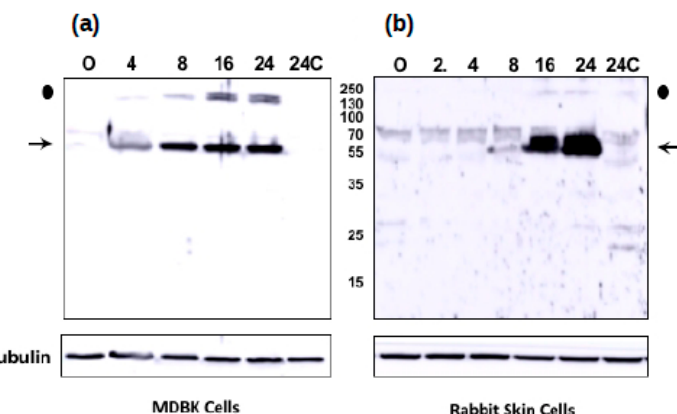
Figure 7. Immunoblot for ORF-A protein production. MDBK (panel a ) or RS cells (panel b ) were infected with BoHV-1 at the indicated times after infection (hours). Proteins were separated via SDS-PAGE gel (50 ug protein/lane). Western blots were probed using the ORF-A peptide specific antiserum. Tubulin was used as a protein loading control. These results are the average of three independent experiments. A protein around 55 kDa was detected in both infected cell types. Peptide-speific antisera from two rabbits yielded similar results in both cell lines. Data from only one antiserum is shown here.